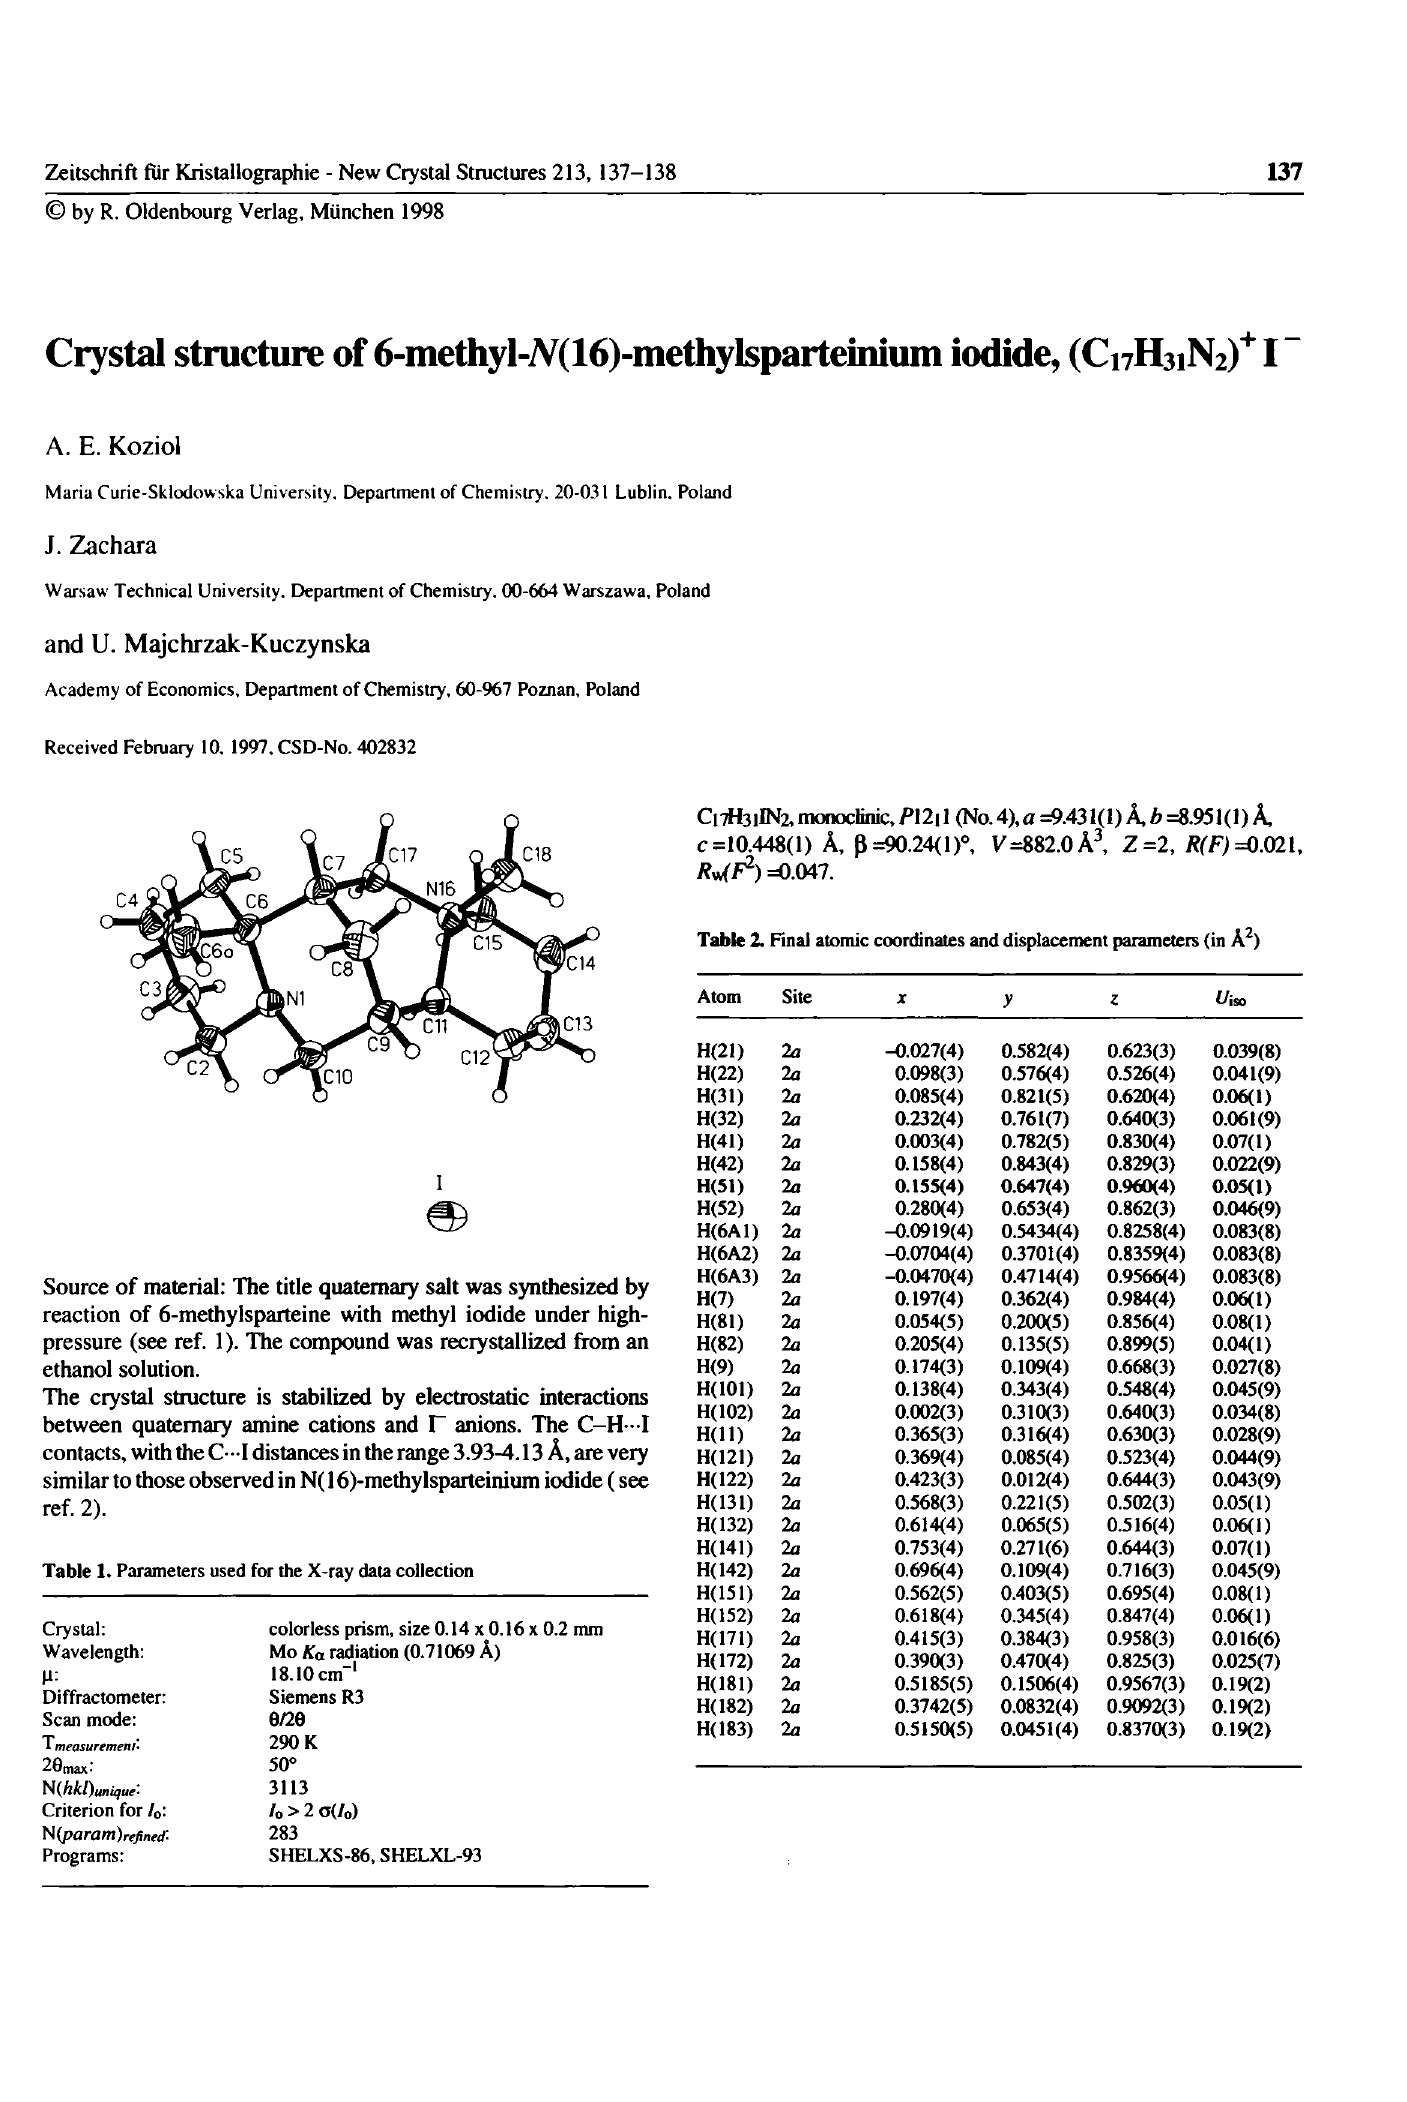
Table 1. Parameters used for the X-ray data collection Crystal: